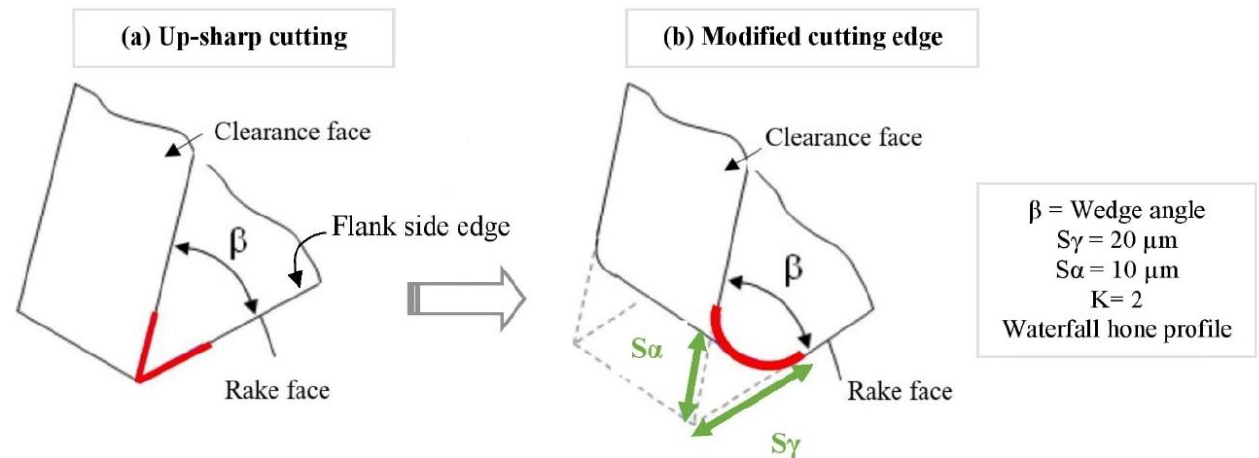
Figure 2. ( a ) Set-up of saws at the chamber of PVD coating system, ( b ) Coated zone on a circular saw.